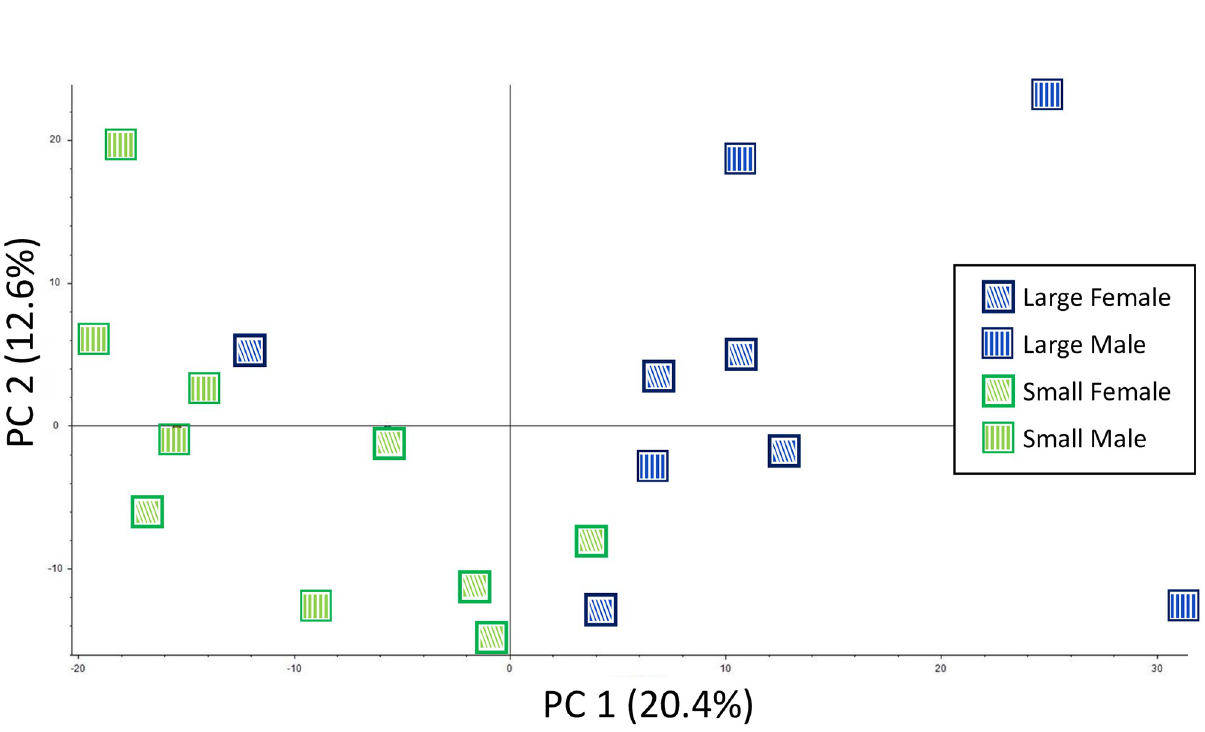
Fig 2. Principal component analysis of all samples used in this research. Blue and green represent large and small animals, respectively. Diagonal stripes and vertical stripes represent females and males, respectively. Note that one of large animal samples has been removed due to misplacement during sample preparation (see Methods